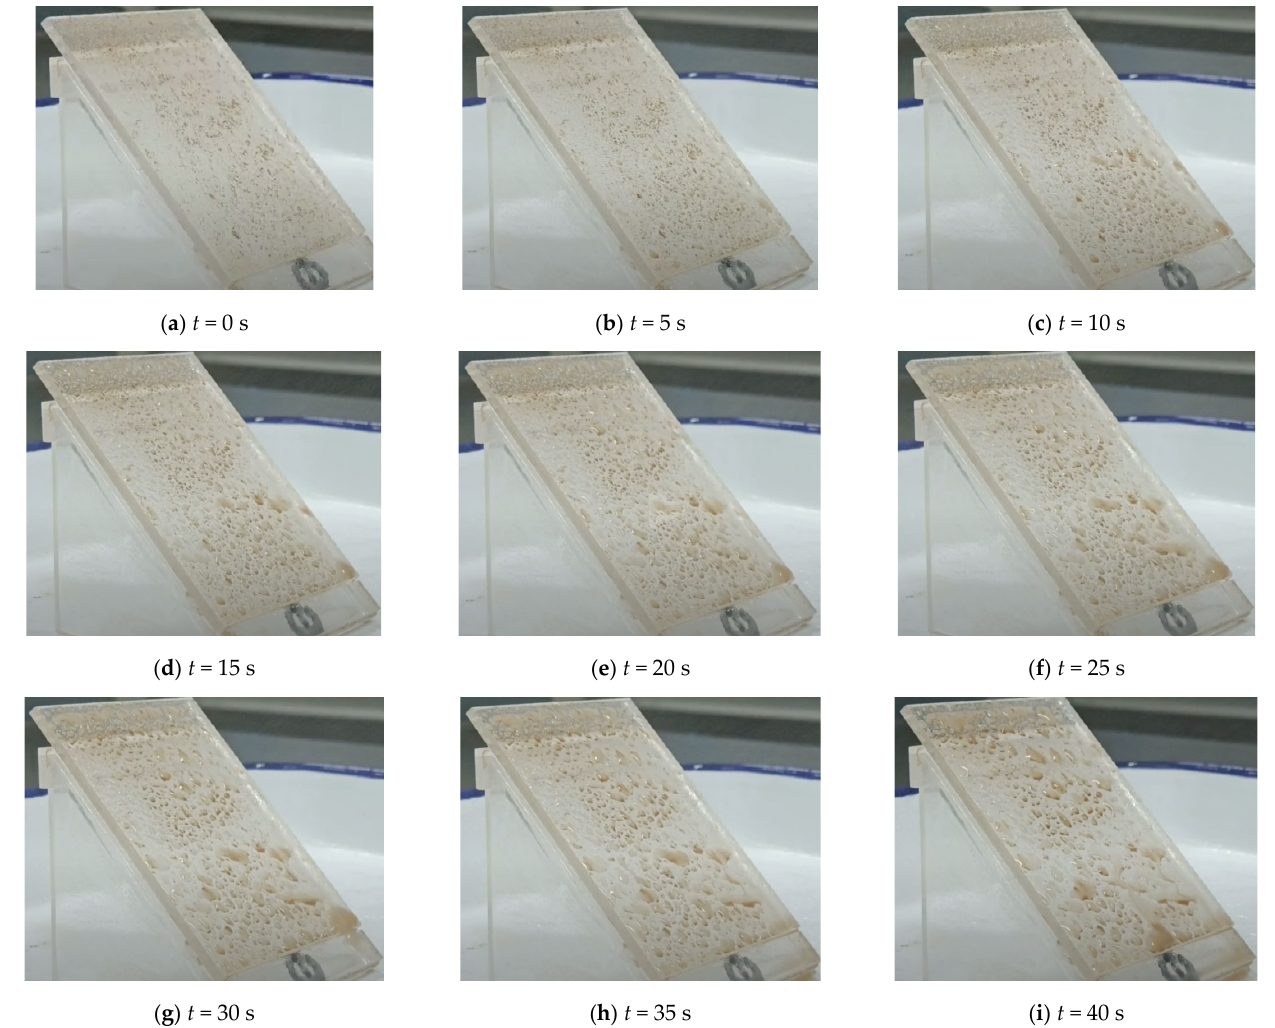
Figure 9. Dust cleaning process under water spraying for the bare surface. Figure 10. Dust cleaning process under water spraying for the bare